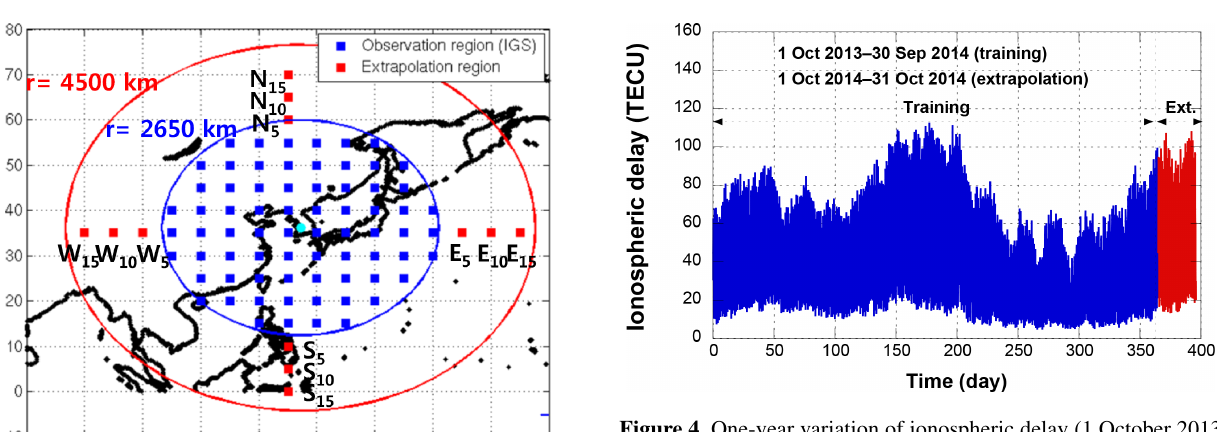
Figure 4. One-year variation of ionospheric delay (1 October 2013 to 30 October 2014, S15 (south 15 ◦